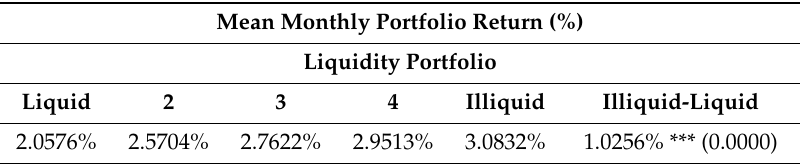
Table 2. Average monthly returns for quintile portfolios.